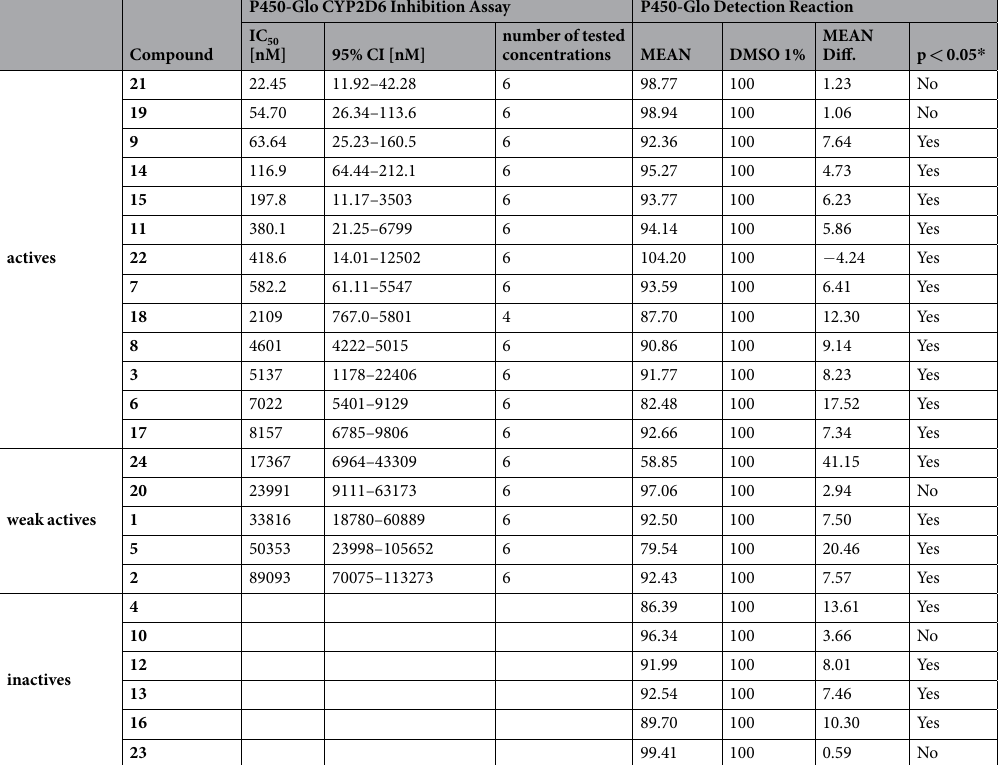
Table 1. Comparison of the CYP2D6-inhibition to the detection reaction-inhibitory potential of the tested natural compounds. The compounds are ranked according to their corresponding IC 50 values for CYP2D6 inhibition. * The p value refers to the ability of the respective compound to inhibit the P450-Glo detection reaction